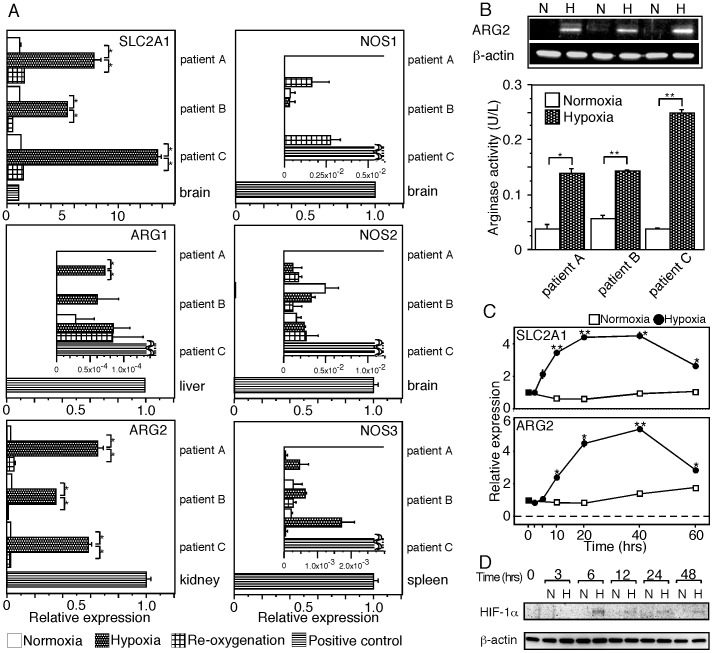
Hypoxia induces expression of ARG2 in CAFs extracted from PDC tissue.(A) Relative gene expression is measured by real-time RT-PCR in fibroblasts extracted from PDC tissue after 48 hrs of exposure to hypoxia (Hypoxia) or culture under normoxic control conditions (Normoxia). Expression of the genes in the fibroblasts after 48 hrs of culture under hypoxic conditions followed by 48 hrs of culture under normoxic conditions (Re-oxygenation) was also analyzed. Each data column represents the mean relative expression standardized with 18SrRNA ± SE for triplicate determinations. The SLC2A1 (alternatively known as glucose transporter type 1 or GLUT1) gene is hypoxia-inducible. Significance value (Student’s t test) of P<0.01 (*). Some genes are expressed in CAFs at an extremely lower level than in a normal tissue that is the major tissue of expressing the gene. In such cases, comparison of gene expression is shown in the insets with 1/50 to 1/10000 scales. (B) Western blot analysis (upper column) reveals that ARG2 protein expression is induced in CAFs used in (A) upon exposure to hypoxia. N and H indicate the cells cultured under normoxic and hypoxic conditions, respectively. ARG2 protein induced in CAFs has arginase activity (lower column). One unit of arginase converts 1 µmol of L-arginine to ornithine and urea per minute at pH 9.5 and 37°C. Each data column represents the mean activity ± SE for triplicate determinations. Significance value (Student’s t test) of P<0.05 (*) and P<0.01 (**). (C) Expression of genes in CAFs from PDC tissue during cultivation under hypoxic conditions detected by real-time RT-PCR. Data represent one of three independent experiments. Significance value (Student’s t test) of P<0.01 (*) and P<0.001 (**). (D) Western blot analysis of HIF-1α protein. Accumulation of HIF-1α protein is observed in CAFs after 6 hrs of exposure to hypoxic conditions. N and H indicate cells cultured under normoxic and hypoxic conditions, respectively.